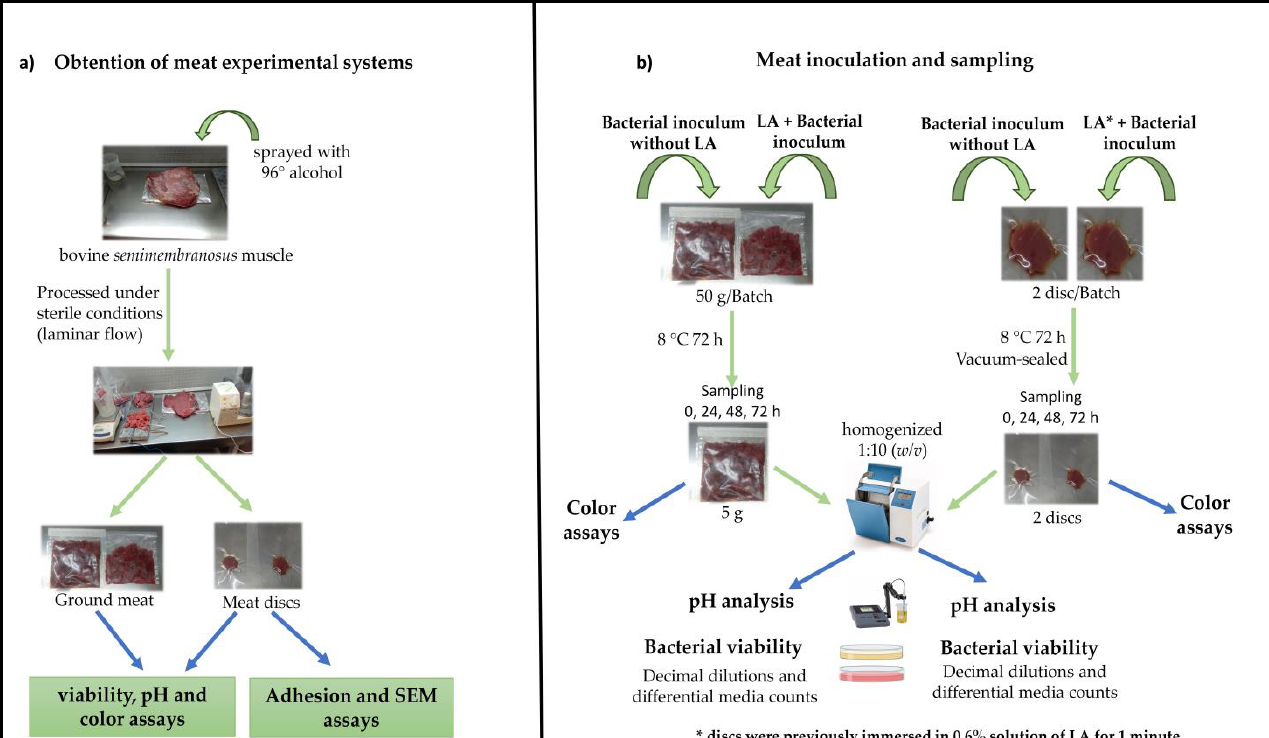
Figure 1. Schematic description of ( a ) experimental systems preparation and ( b ) meat inoculation and analysis.